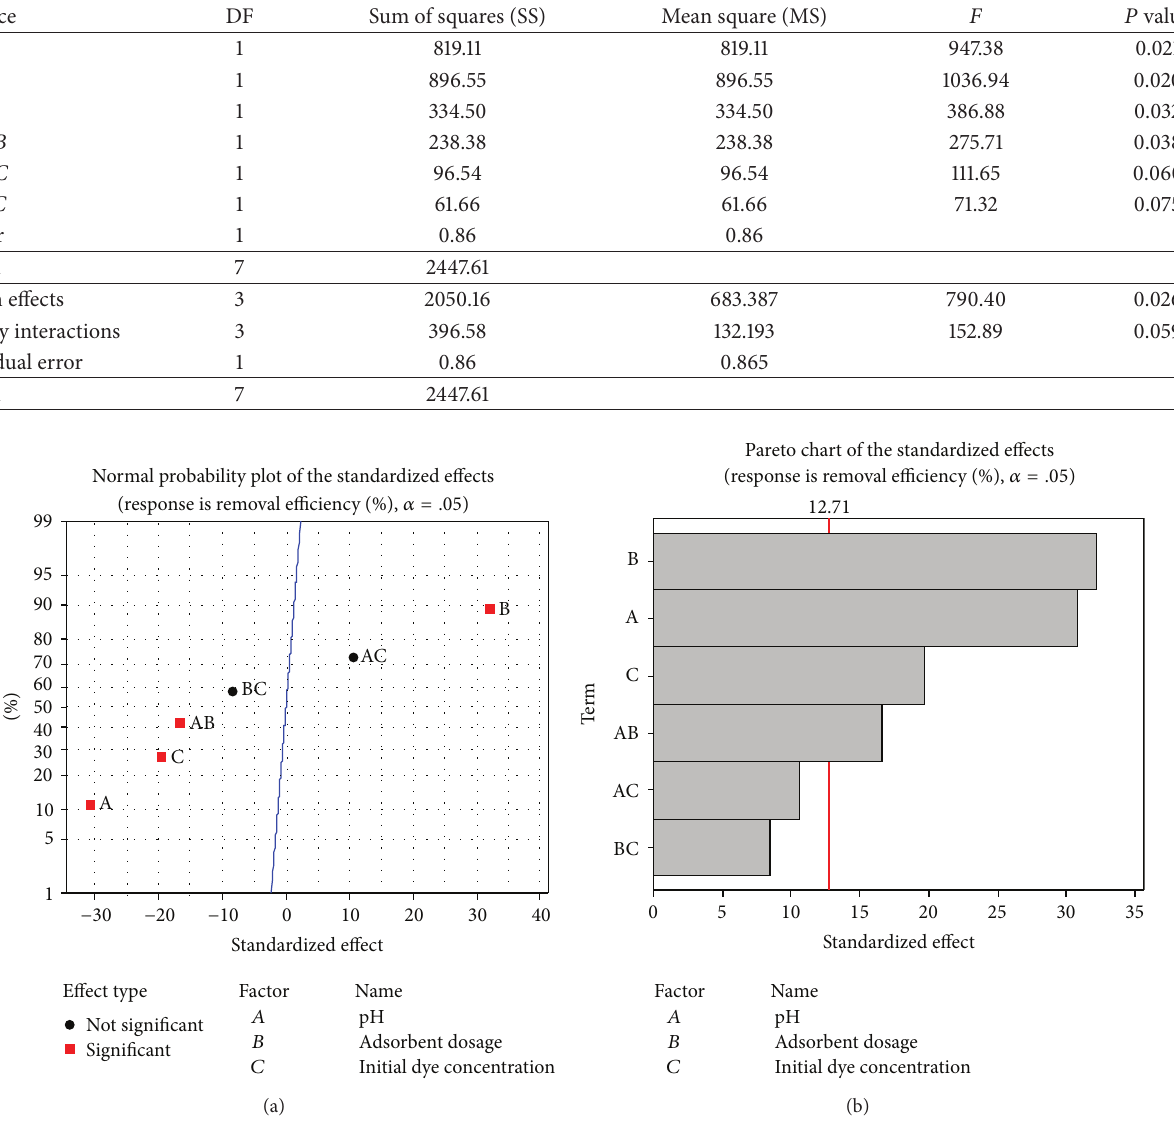
Figure 9: (a) Normal probability plot of the standardized effects at 𝑃 = 0.05 , (b) Pareto chart of standardized effects on the removal efficiency (%) for